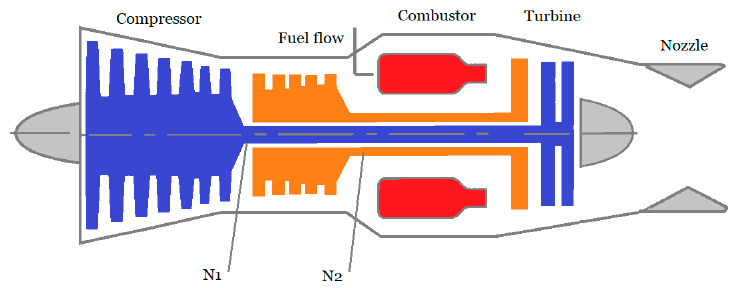
Figure 1. Simplified structural diagram of a gas turbine engine as a control object.